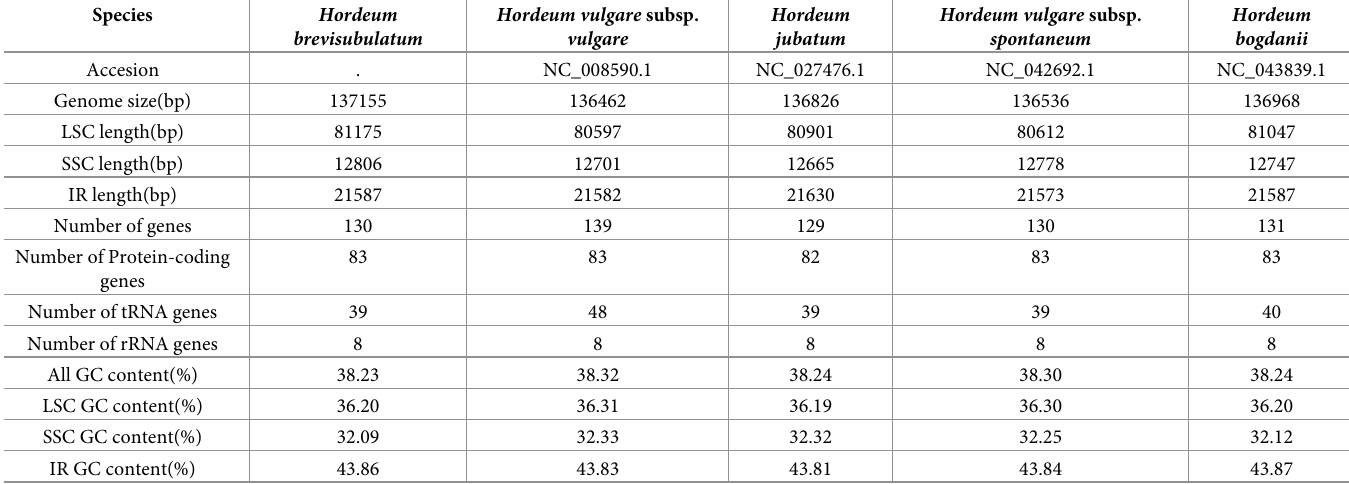
Table 3. Summary of five Hordeum chloroplast genome features.